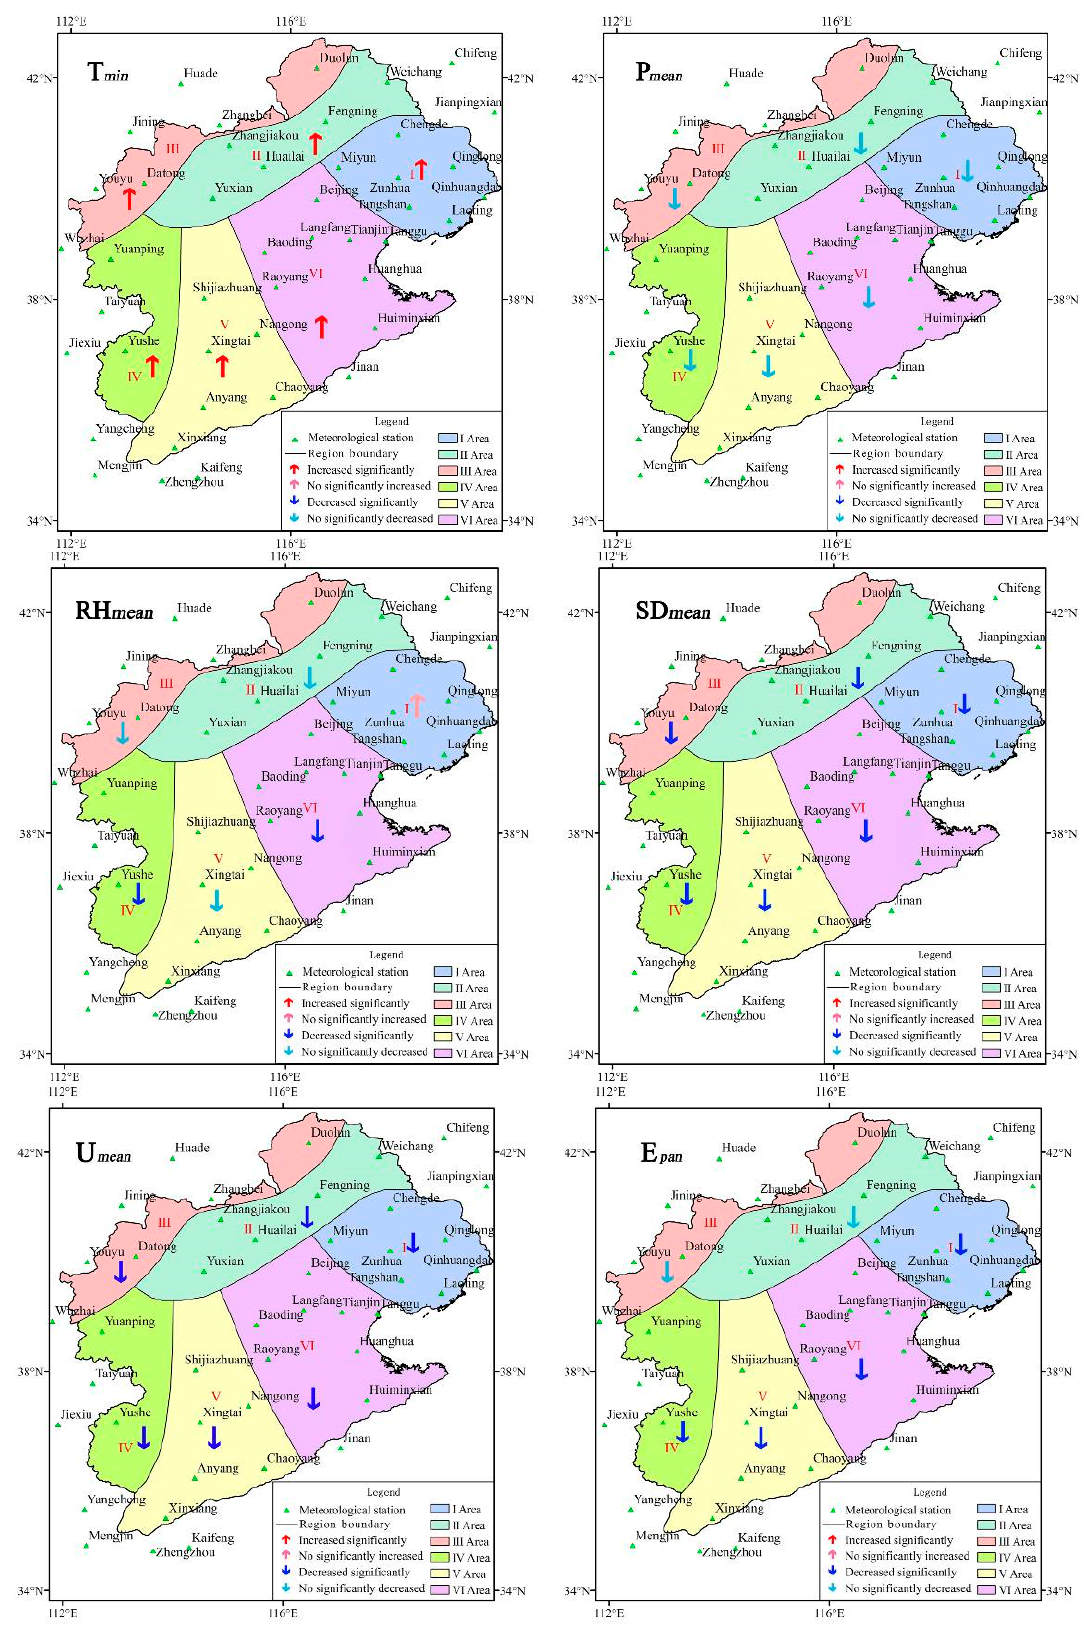
Figure 4. Results of significance test on the interannual variations of the meteorological elements.